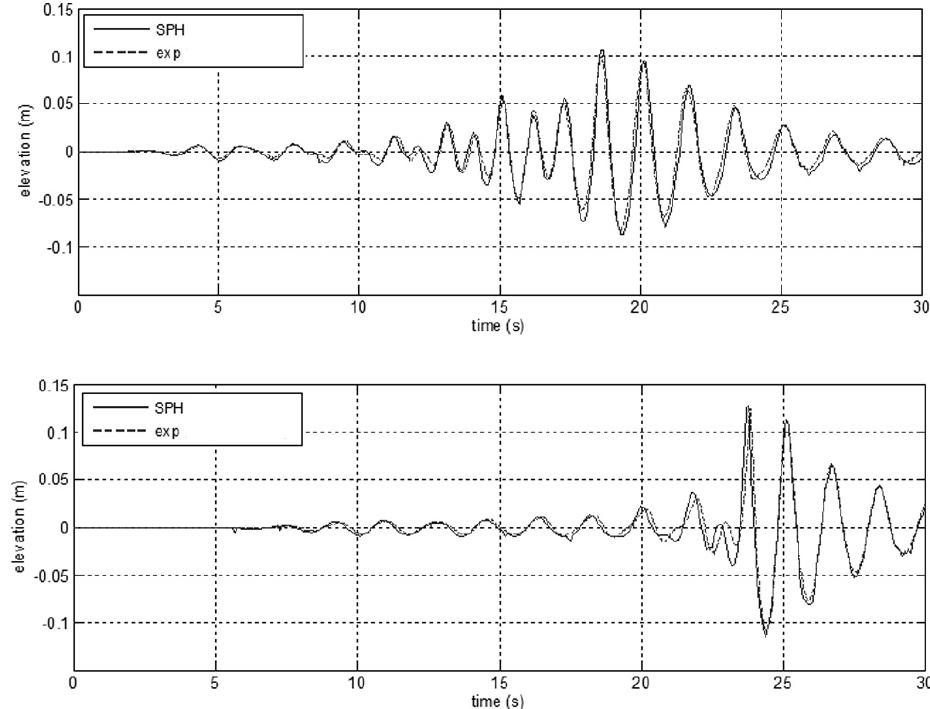
Fig. 7. Comparisons of simulated and measured water elevations at two locations 4.5m (upper pane) and 12m (lower pane) from the mean paddle position.